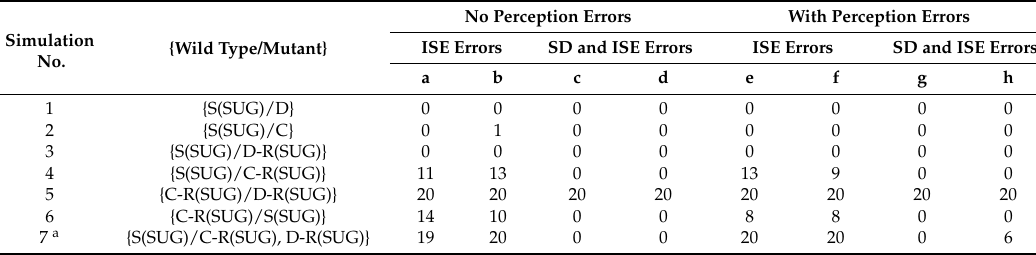
Table 6. Frequency of successful invasions under sugden .